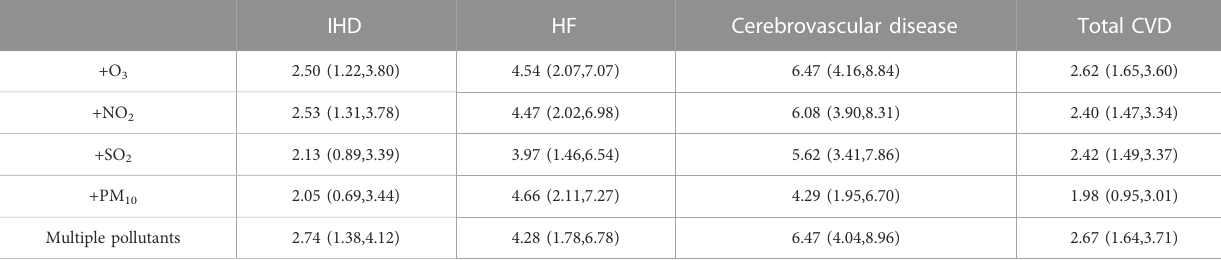
TABLE 4Adjusted percentage changes in co-pollutants and multiple pollutants per 1 mg/m 3 increase in the concentration of CO for total and cause-speci fi c